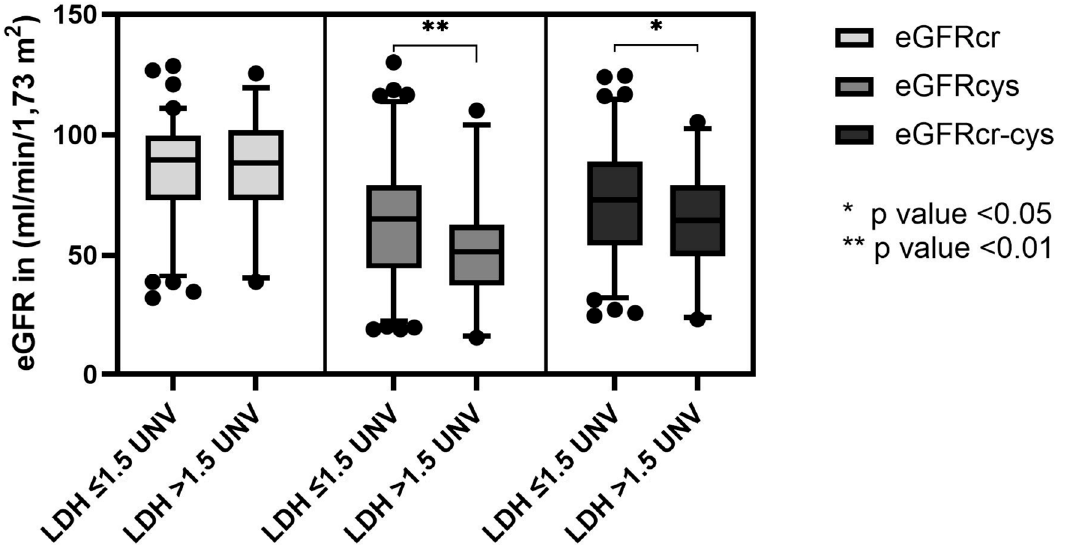
Figure 5. Significant difference in eGFR between LDH ≤ 1.5 UNV and >1.5 UNV in eGFRcys ( p < 0.01) and eGFRcr-cys ( p < 0.05) but not eGFRcr in a Two-tailed paired t